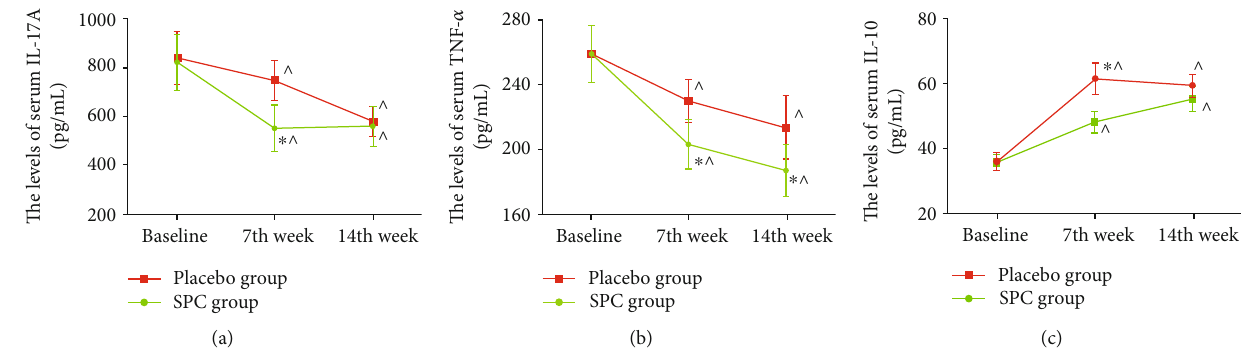
Figure 2: The serum IL-17A, IL-10, and TNF- α level of subjects between the SPC and the placebo groups. Data are presented as mean ± SD . The serums IL-17A (a), TNF- α (b), and IL-10 (c) of subjects in both groups were assayed at baseline, 7 th week, and 14 th week. ∗ p < 0 : 05 , relative to the placebo group, ∧ p < 0 : 05 , relative to